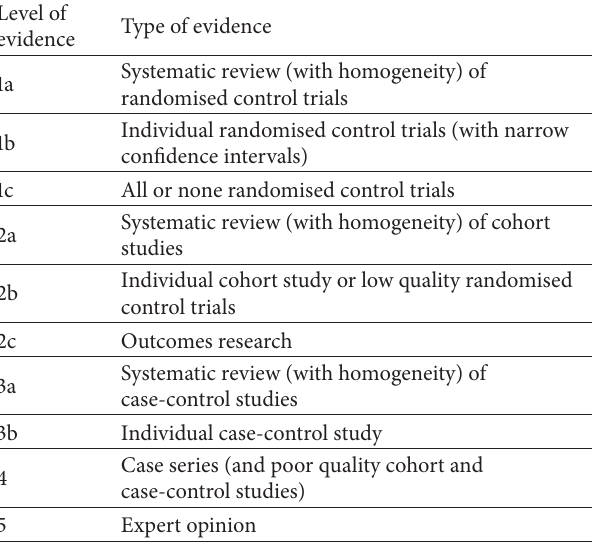
Table 5: Levels of evidence